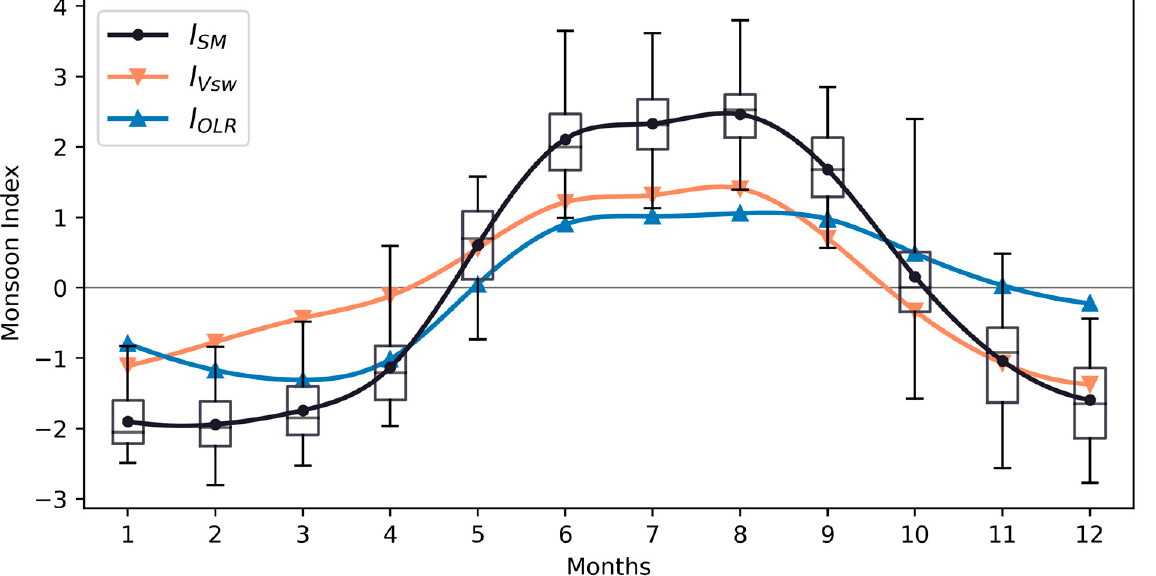
Figure 2. Seasonal circulation curves of the SCSSM intensity index ( I SM , black curve), southwest wind index ( I Vsw , orange curve), and the OLR index ( I OLR , blue curve) for each month of the multi-year average. The boxes and whiskers are the monthly I SM of multi-year ranges.